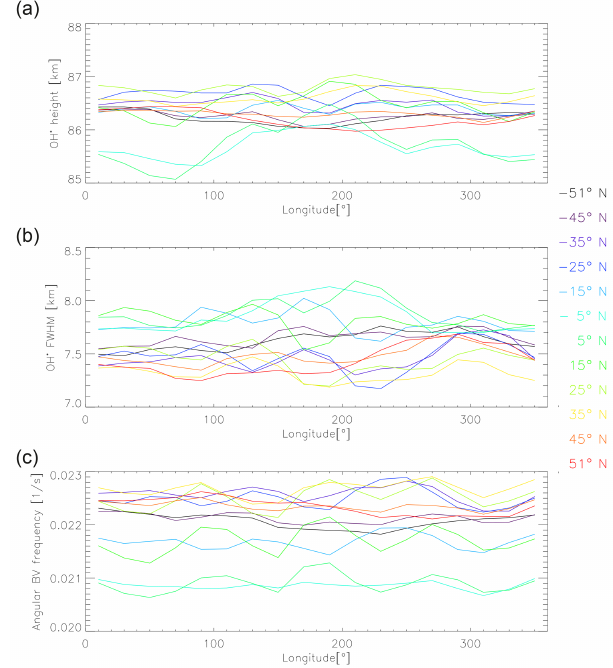
Figure 2. OH ∗ -layer height (a) , FWHM (b) and OH ∗ -equivalent BV frequency (c) are averaged over all years and plotted for the latitudinal bands 45 ± 5 ◦ S to 45 ± 5 ◦ N, 50–52 ◦ N/S (colour coded). Please be aware that the axes of the respective plots of Figs. 1 and 2 are not identical.